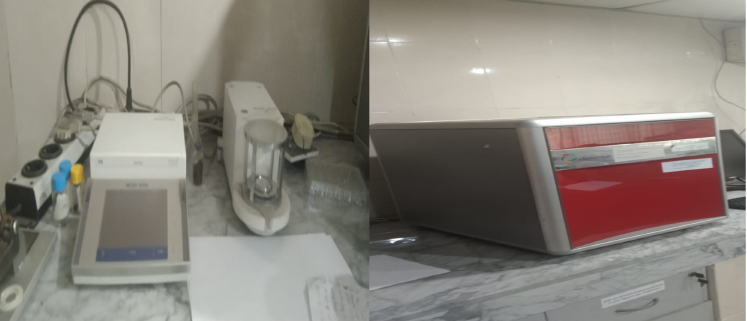
Figure 6. Experimental apparatus for elemental analysis of MSW (Vario Micro Cube,